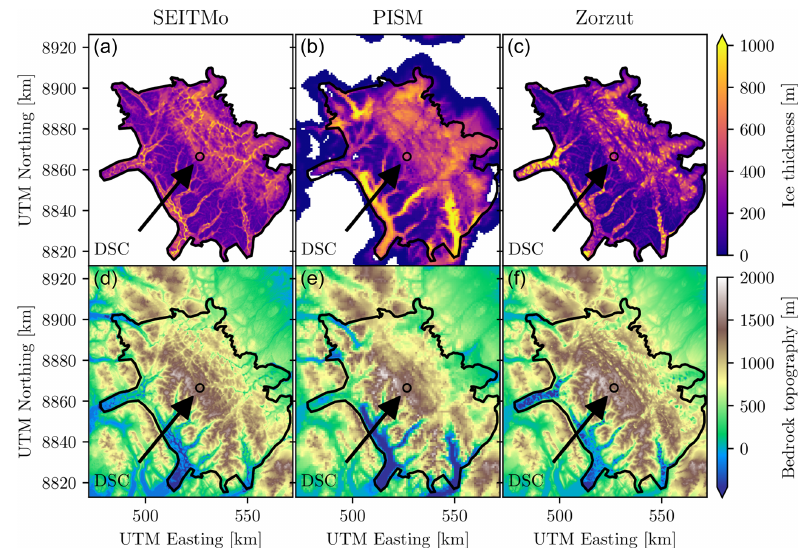
Figure 3. SEITMo thickness (a) and bedrock topography (d) . PISM ice thickness (b) and bedrock topography (e) . Zorzut ice thickness (c) and bedrock topography (f) . The black polygon in all panels marks the present-day ice cap margin as used in the SEITMo and Zorzut. The proposed drill site candidate (DSC) is marked in all panels. Coordinates are given in UTM zone